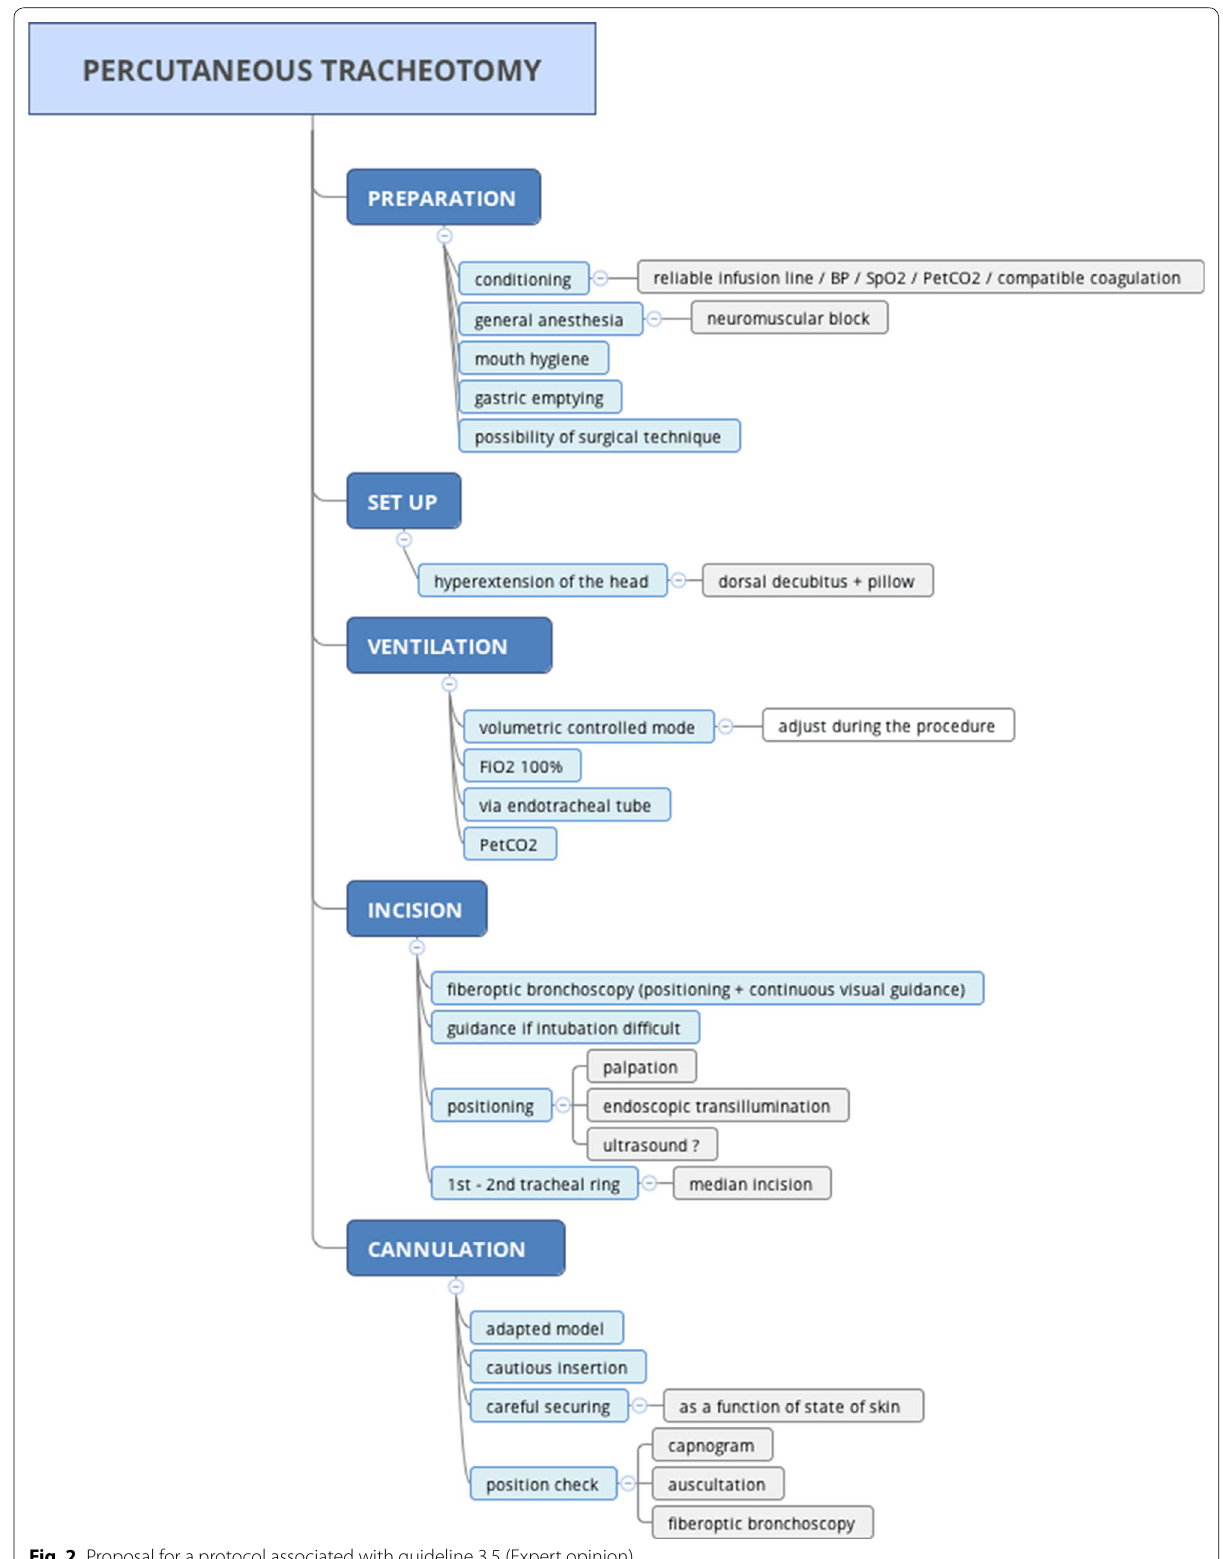
Fig. 2 Proposal for a protocol associated with guideline 3.5 (Expert